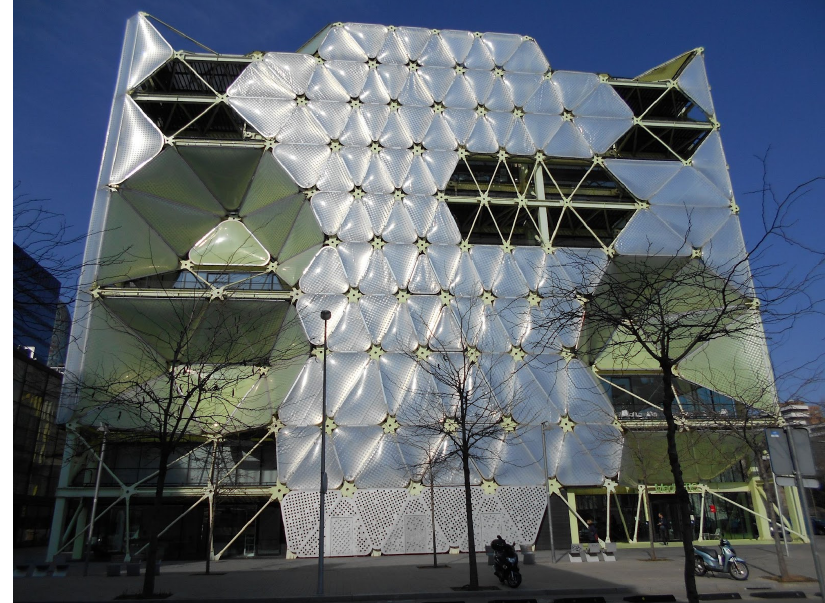
Figure 2. MediaTIC building ETFE cushions façade. Source: authors.